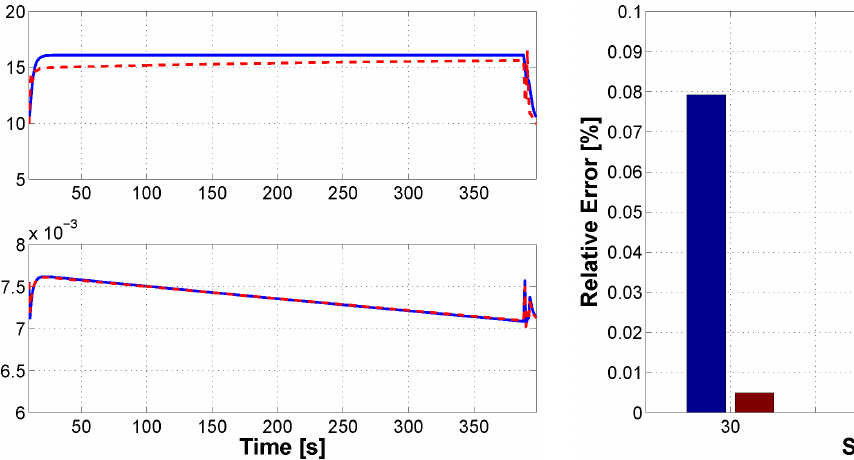
Figure 24: Time histories of real and observed values of TPP-AOA (top) and thrust coeflcient (bottom) for 5 ∘ glide slope, 40 kn air- speed. Blue solid line: real values. Red dashed line: observed val- ues.